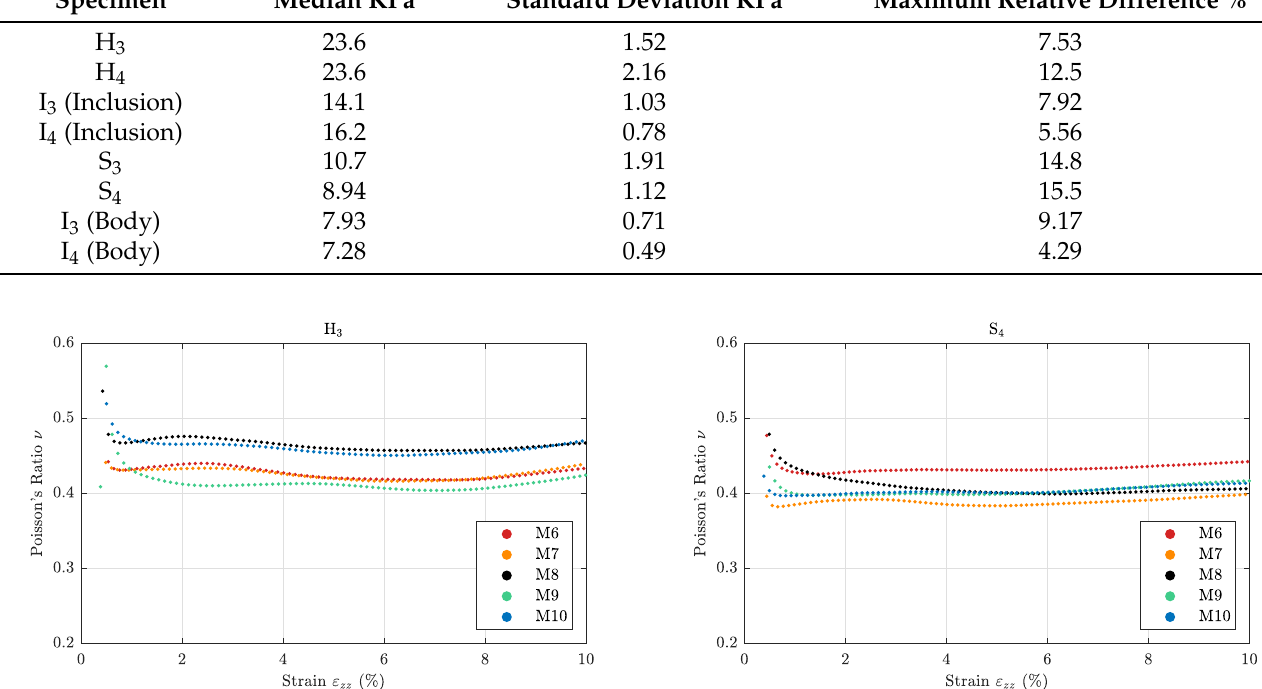
Figure 17. Strain-dependent Poisson’s ratio ν of the homogeneous specimens.